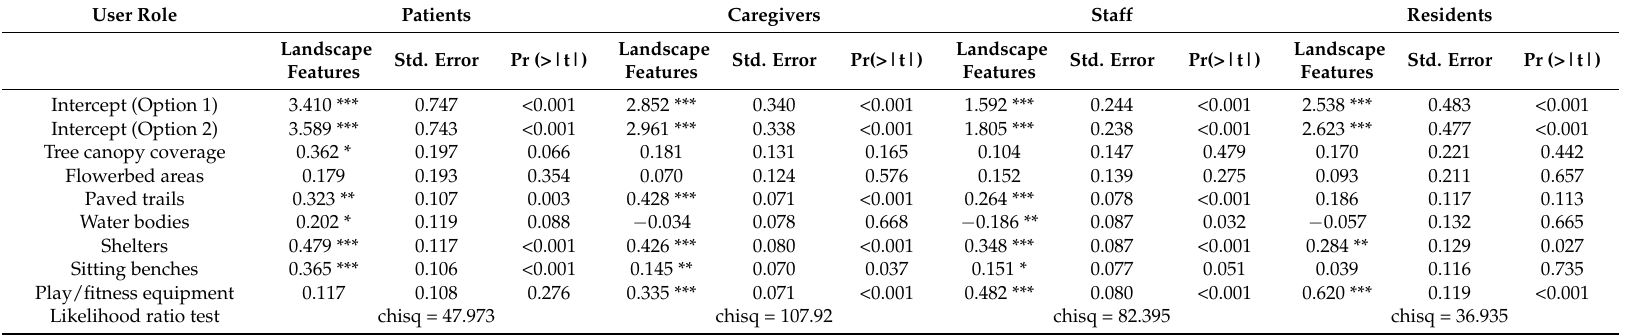
Table 5. The estimates of landscape features on visitation intent of different user groups.